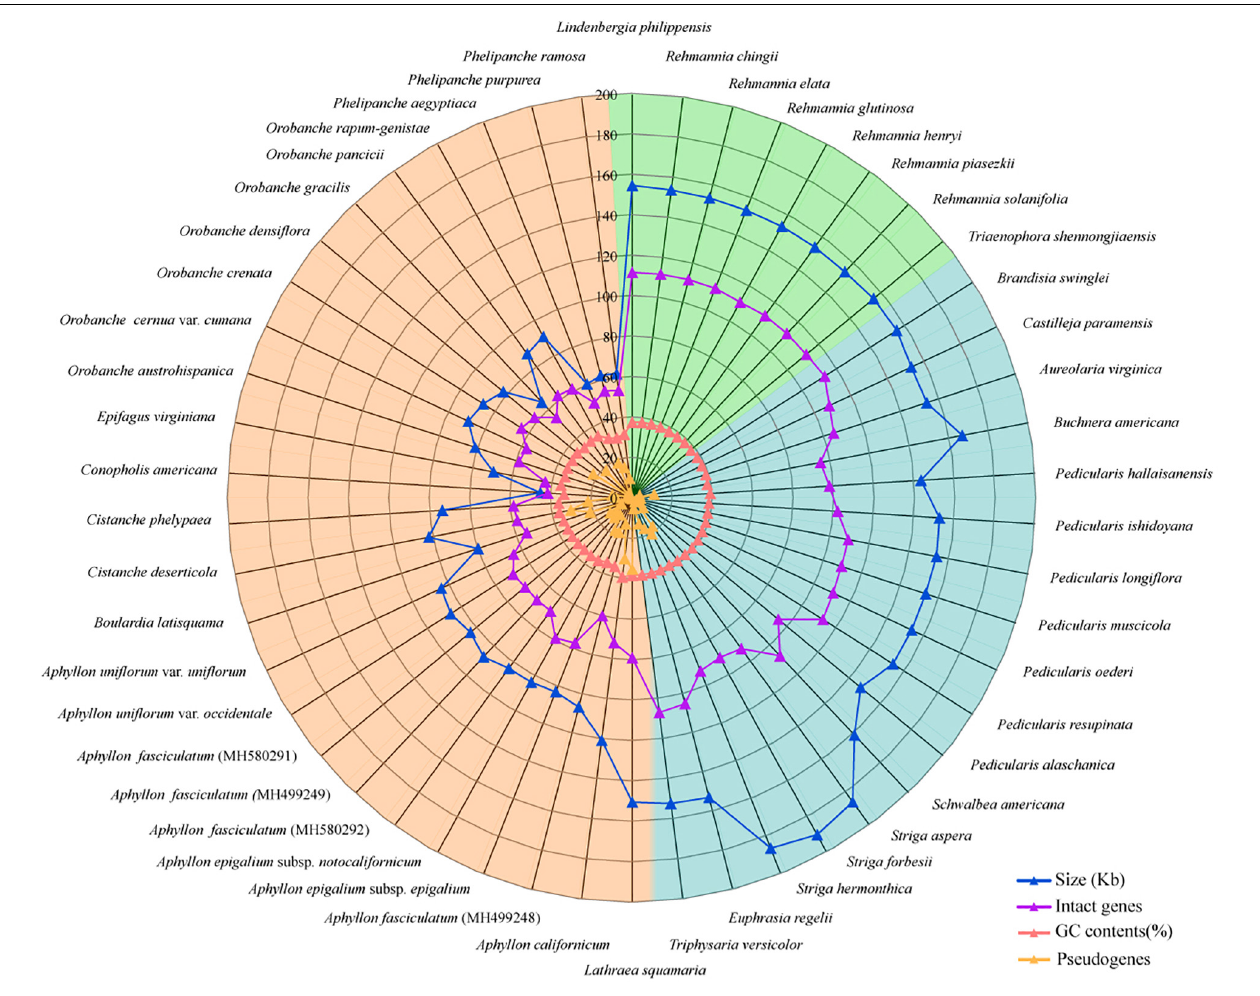
FIGURE 1 | A radar-plot for comparing features of the complete chloroplast genomes in 50 Orobanchaceae species. From inside to outside: pseudogenes, GC contents, number of protein-coding genes, and genome sizes. The background colors of green, blue, and orange represent autotrophic, hemiparasitic, and holoparasitic species,